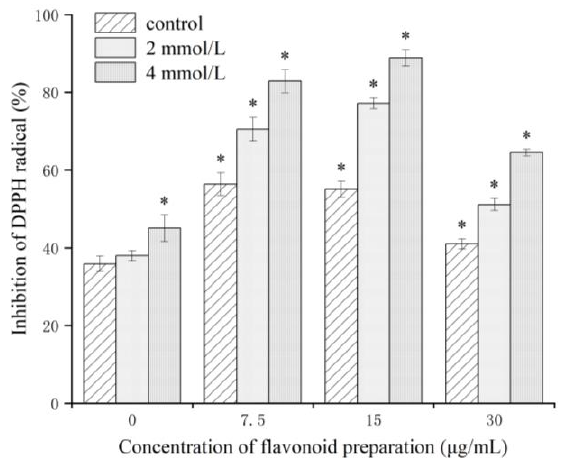
Figure 9. Effect of flavonoid pretreatment on antioxidant activity, expressed as the percentage of inhibition of DPPH radicals in C. drupifera leaves. * indicates statistical significance ( p < 0.05).